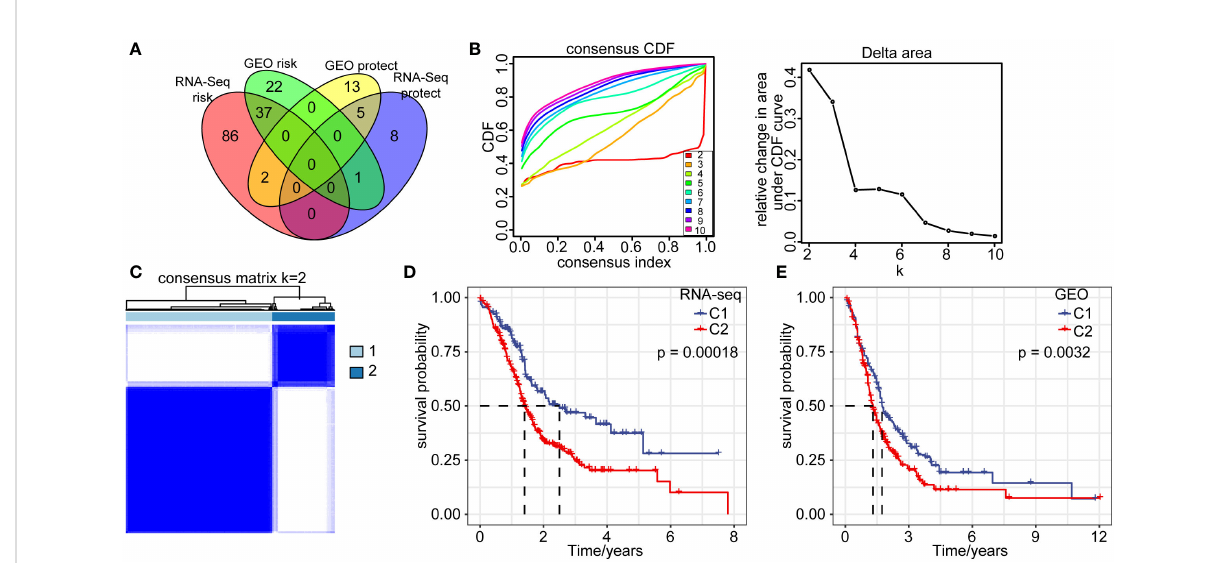
FIGURE 3 Molecular signatures of cancer cells. (A) Venn diagram overlap of 352 marker genes in cancer cells from two cohorts by single factor analysis. (B) CDF curve and CDF delta area of RNA-seq queue sample. (C) Heatmap of RNA-seq sample clustering (consensus k=2). (D) Overall survival curves of C1 and C2 subtype in RNA-seq dataset. (E) Overall survival curves of C1 and C2 subtype in GEO